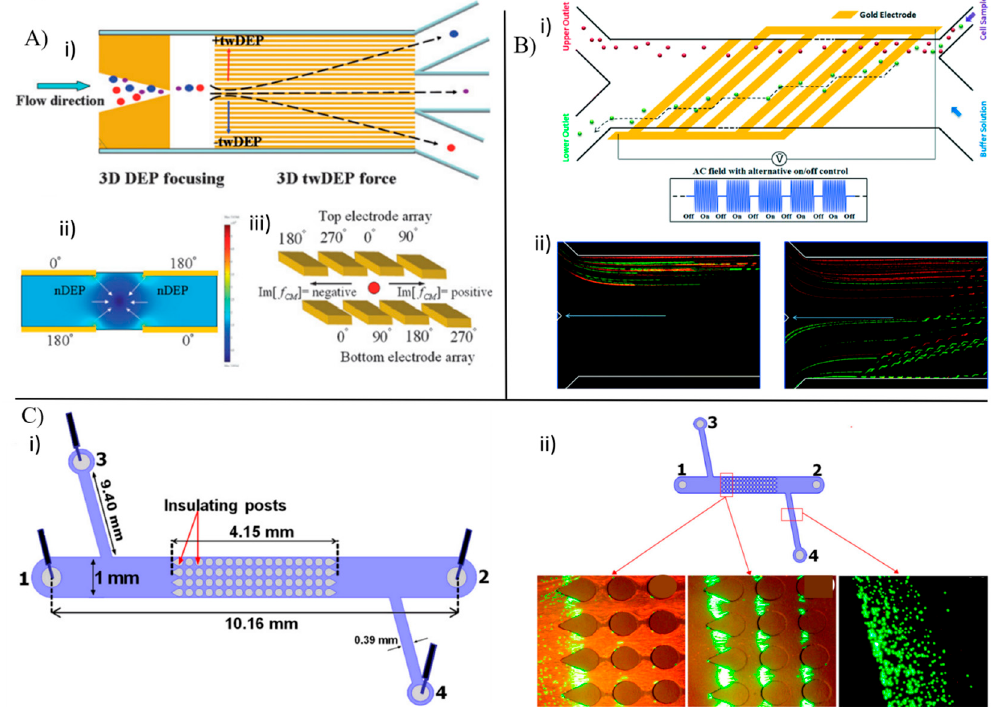
Figure 2. Dielectrophoresis-based cell trapping ( A ) (i) Top view of the twDEP electrode design showing the separation of particles, (ii) side view of the electrode displaying repulsion of particles because of nDEP, and (iii) 3D view of the top–bottom electrode arrays displaying pDEP and nDEP leading to the particle separation into different directions (reproduced with permission from [70]). ( B ) (i) Schematic representing microfluidic system based on continuous flow-multiple DEP with the AC field turned on and off alternately, as depicted in the graph; (ii) Different cells (hMSCs stained in red, osteoblasts stained in green) follow the same trajectories in the absence of an electric field, whereas osteoblasts deflect and travel in the bottom part of the channel in the presence of an applied electric field (reproduced with permission from [72]). ( C ) Image of an insulator-based microfluidic DEP device showing (i) four channel reservoirs (1–4) based on insulating posts fabricated in the microchamber; (ii) Capturing (left), enrichment (middle), and isolation (right) of green particles (2 µm) after flushing out of red (500 nm) particles to waste reservoir 2 (reproduced with permission from [73]). 3.1.4. Magnetophoresis Electromagnets or permanent magnets can also be used to separate and sort individ- ual cells for analysis. Since cells normally lack paramagnetic characteristics, surface tag- ging of cells with immunomagnetic beads is required. Because of the interactions between the cell surface antigen and the antibody-tagged nanomagnetic beads, they were attached to the surface of the cell in a specific manner. Cellular magnetic manipulation is conven- ient as it is easy to operate, because no heat is generated and contact with samples is also not required in this process. Moreover, the magnetic field and magnetism are not affected by the pH, ionic strength, and temperature of the surroundings [77]. Zhou et al. fabricated a PDMS-based microfluidic device exploiting magnetic forces to separate target particles from non-target particles in the samples. This device included two different parts—a separator, in the latter part where magnetic fractionation due to a magnetic field separates trapped target components from non-target components, and a cell incubator. This device trapped and isolated more than 90% of the target components and eliminated more than 99% of non-target components present in the sample. Integra- tion of an incubator with the magnetism-based separator eliminates the need for manual off-chip incubation and makes automated separation and recovery of certain microparti- cles possible [78]. Hoshino et al. extracted cancer cells tagged with magnetic particles and